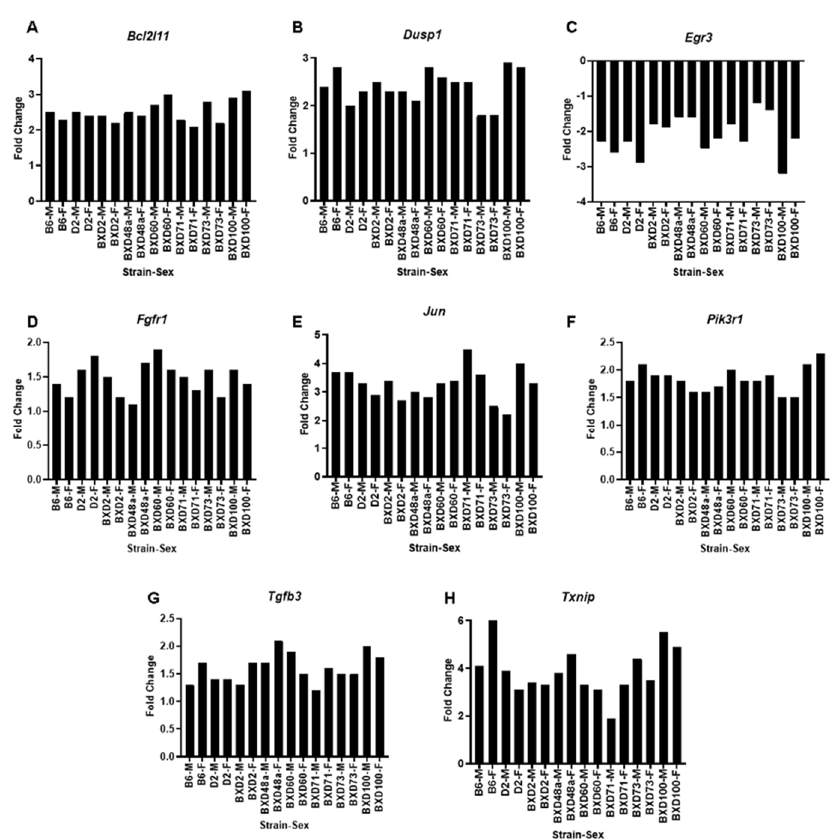
Figure 6. Apoptosis-related genes that show strain × treatment interaction and fold-change greater than 1.5. BXD and parental strains showed significant ( adjp < 0.05; FC > 1.5) differential expression of many apoptosis-related genes including: ( A ) Bcl2l11 , ( B ) Dusp1 , ( C ) Egr3 , ( D ) Fgf1 , ( E ) Jun , ( F ) Pik3r1 , ( G ) Tgfb3 , and ( H ) Txnip . For each graph, the x-axis lists the strain and sex (M = male, F = female) and the y-axis represent the fold change relative to saline controls.